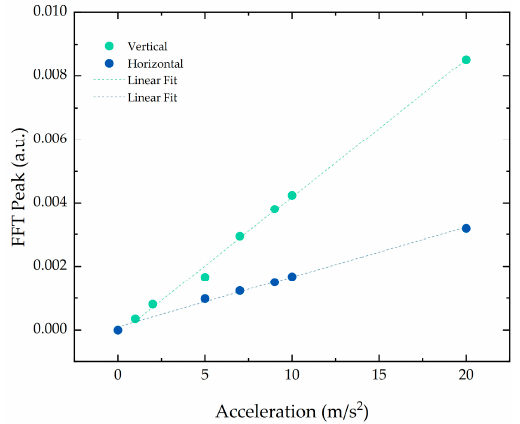
Figure 6. Signal peak value at 100 Hz for the different accelerations applied directly to the structure for the (green) vertical and (blue) horizontal direction.